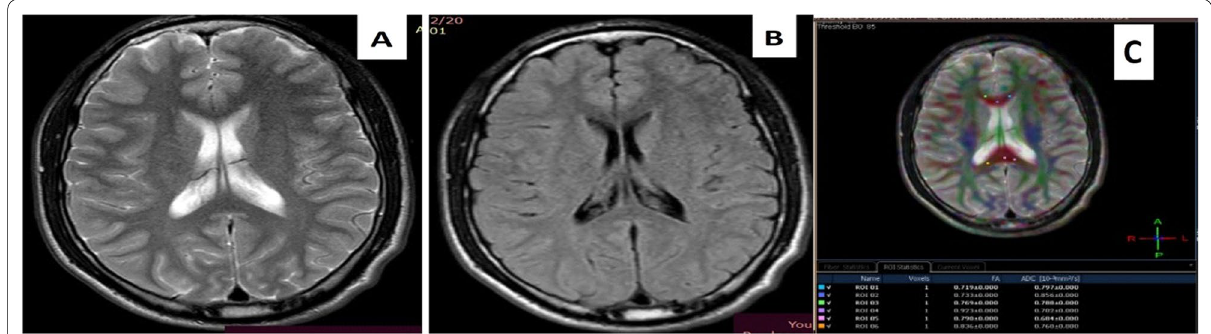
Fig. 1 Male patient aged 25 years old with trauma since 2 weeks came with drowsiness, came with GCS 15. No detected any abnormalities in conventional MRI images T2 and FLAIR ( A and B ). DTI image C of both genue and splenium of corpus callosum show affection of genue on right side mean FA less than 0.751 and ADC more than 0.706 and affection right side splenium as FA less than 0.82 and ADC more than 0.743